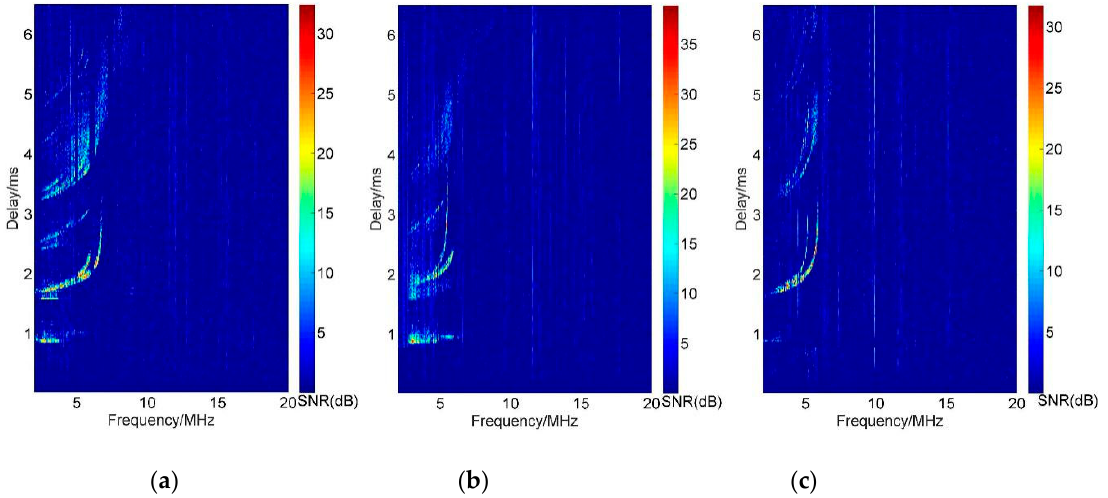
Figure 5. Ionogram of complete complement code sequences: ( a ) Vertical ionogram of Leshan; ( b ) Vertical ionogram of Ningqiang; ( c ) Vertical ionogram of Wuhan.